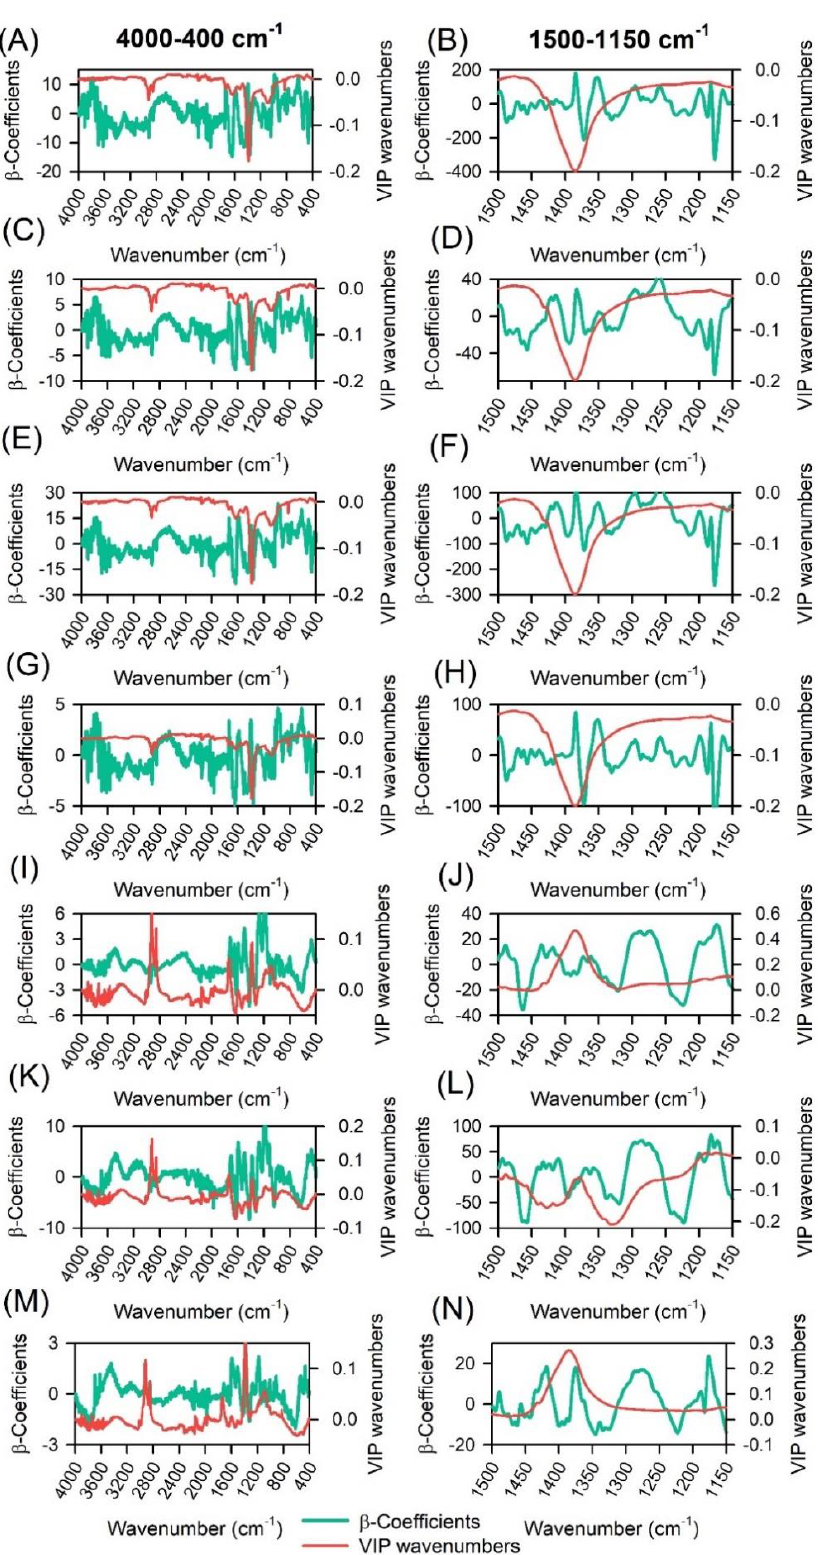
tions for VIP-selected wavenumbers to improve models (Table 4).